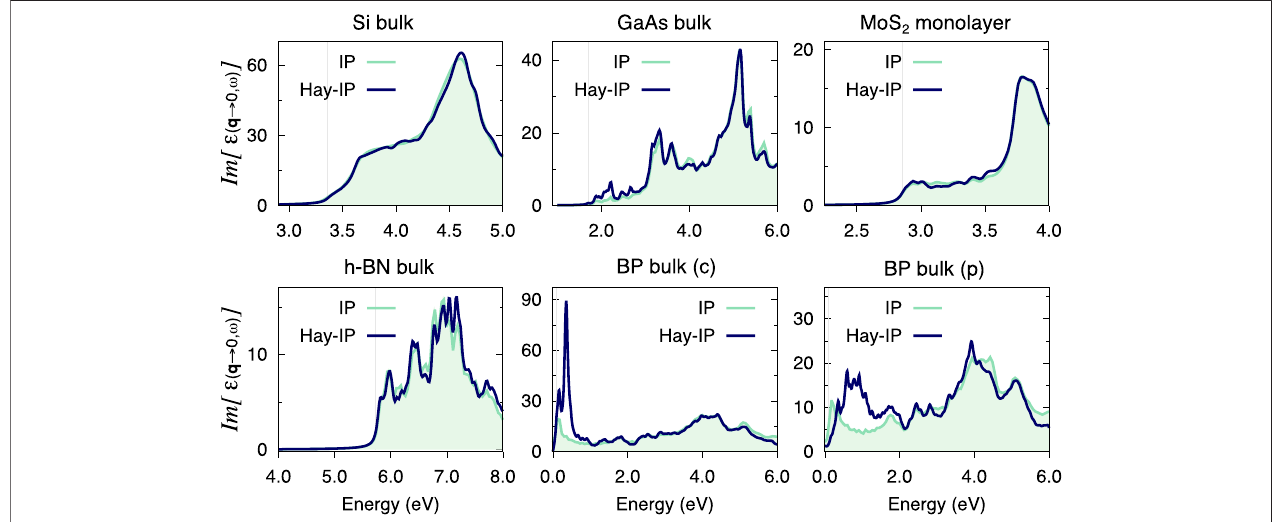
FIGURE 7 | Optical absorption spectra at the IP level calculated with the double grid method (labelled Haydock-IP) and via a full calculation on a fi ne grid (labelled IP), for all materials considered in this study. In all cases, the fi ne grid in the double-grid Haydock-IP calculation is of the same dimensions as the fi ne grid used in full for the IP calculation. The coarse grids and double/ fi ne grids used for each material are listed below. Si: 8 × 8 × 8 and 60 × 60 × 60, GaAs: 10 × 10 × 10 and40 × 40 × 40,MoS 2 :12 × 12 × 1and60 × 60 × 1,h-BN:12 × 12 × 4and24 × 24 × 8,BP(c):14 × 10 × 4and42 × 30 × 12,BP(p):5 × 5 × 6and30 × 30 × 36. All k -grids are